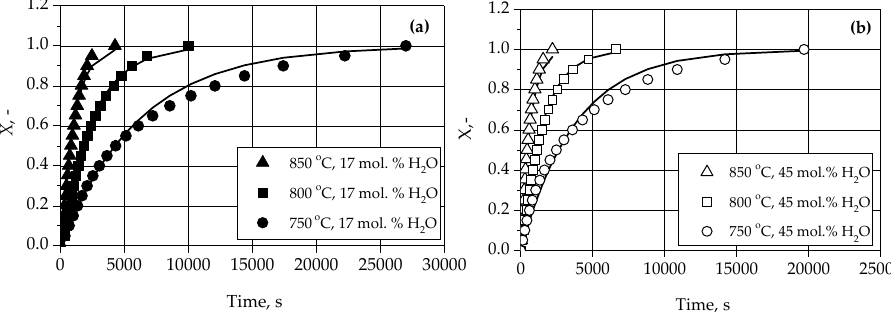
Figure 3. RPC char conversion versus reaction time for the VM (described by Equation (6)), which was the best fitting model prediction for ( a ) 17 mol % H 2 O in Ar, ( b ) 45 mol % H 2 O in Ar.